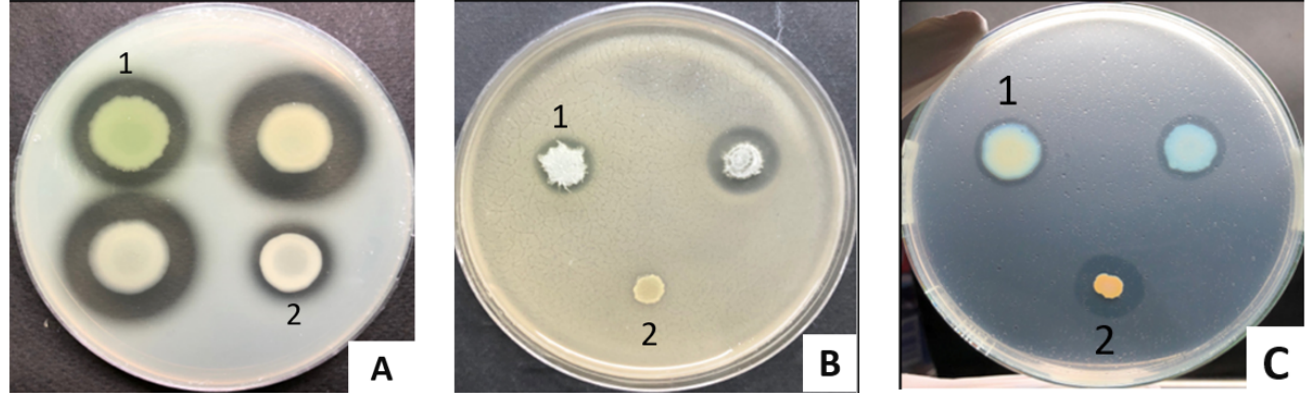
Figure 2. The production of protease ( A ), gelatinase ( B ), and lipase ( C ) of commensal P. aeruginosa isolates. A1, B1, C1: P. aeruginosa ATCC 9027; A2, B2: S. aureus ; C2: V. cholerae ; the others: P. aeruginosa isolates.